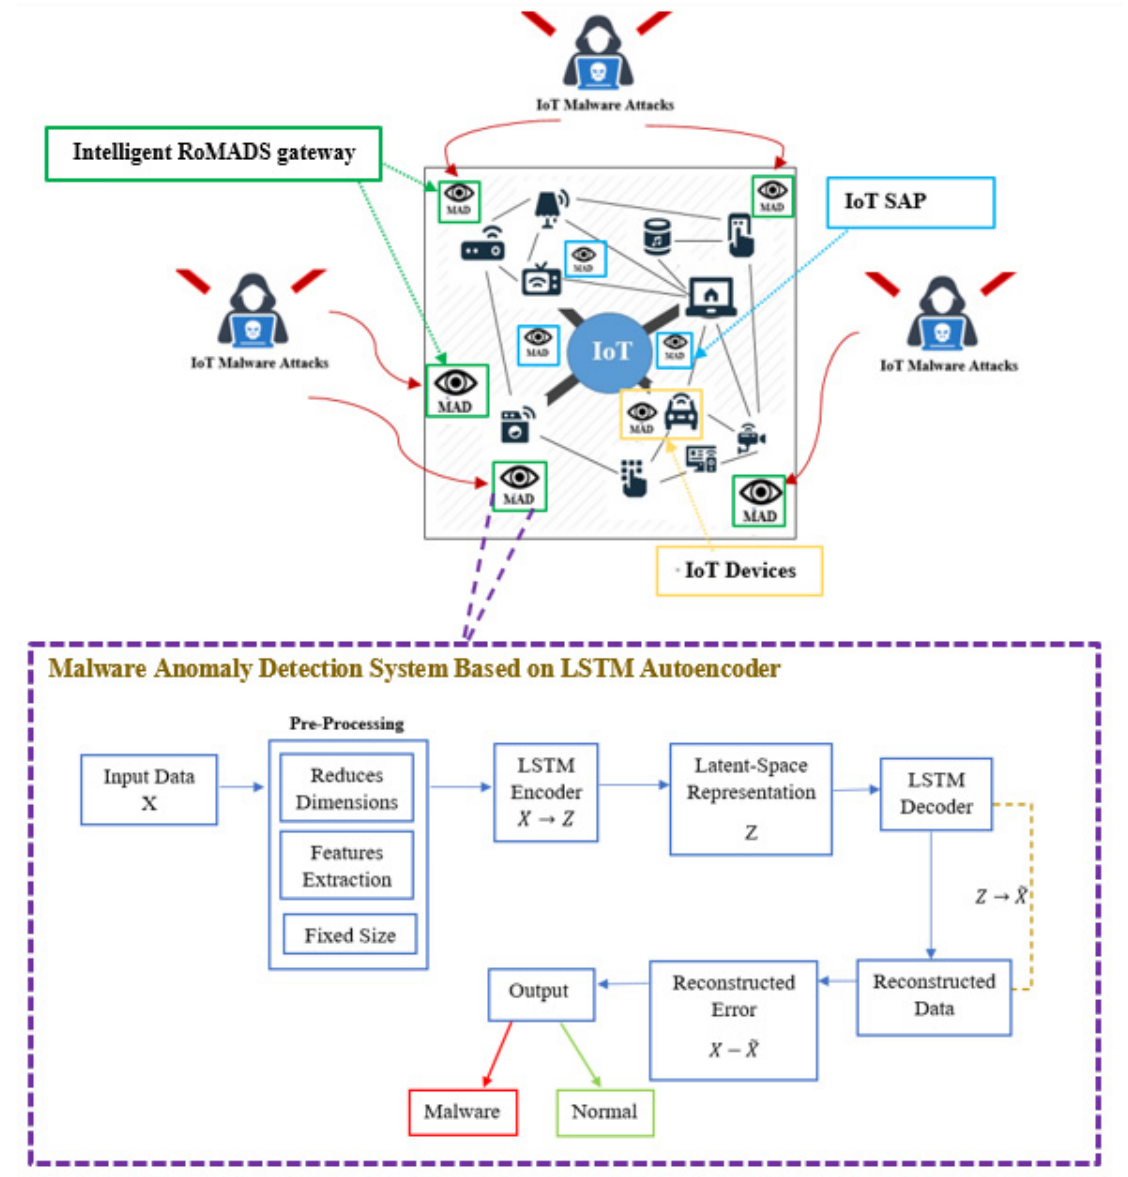
Figure 18. MAD based on LSTM Autoencoder on IoT system.